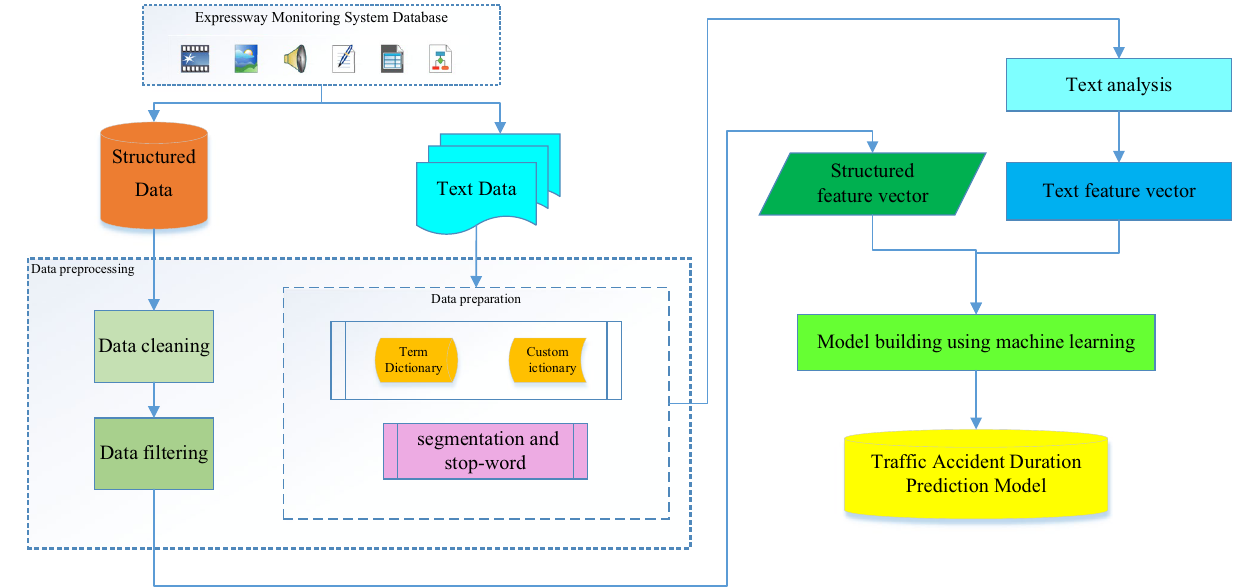
Figure 1. The architecture of traffic accident duration prediction model.